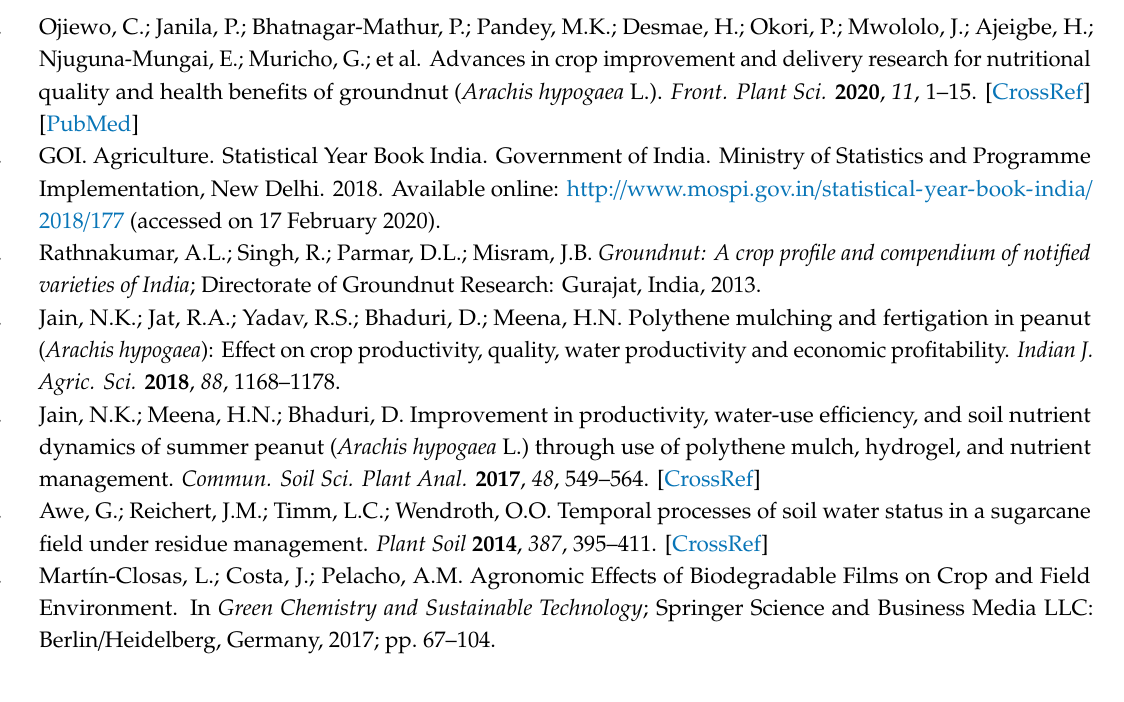
Table S1: Analysis of